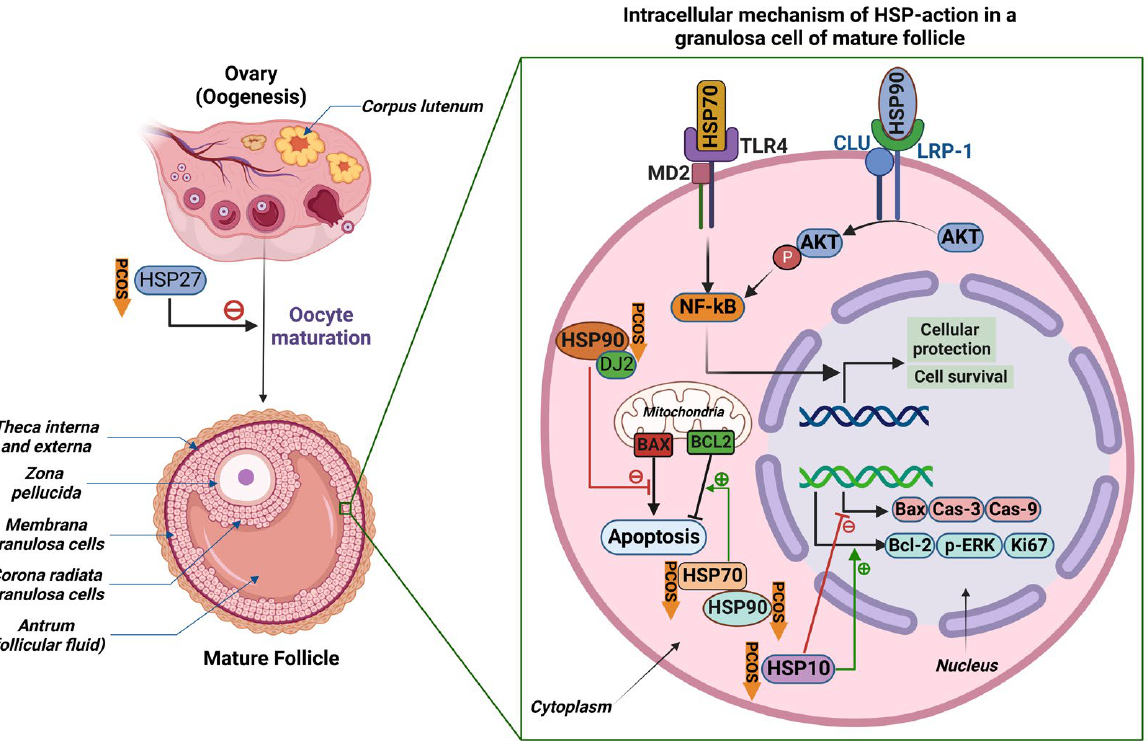
Figure 3. The effect of heat-shock proteins (HSPs) on the pathogenesis of polycystic ovary syndrome (PCOS). ( Left panel ) The stages of oogenesis in the ovary and the structure of a mature follicle. HSPs function at different stages of oogenesis in PCOS. HSP27 negatively regulates oocyte maturation and was downregulated in women with PCOS. ( Right panel ) Intracellular mechanisms of action of HSPs in a granulosa cell (shown in a small green square) of a mature follicle. HSP70 binds to the cell surface toll-like receptor 4 (TLR4) and co-receptor myeloid differentiation protein 2 (MD2). HSP90 binds to the cell surface low-density lipoprotein (LDL)-related protein-1 (LRP-1) in association with clusterin (CLU). Downstream signaling of both HSP70 and HSP90 (phosphorylation of protein kinase B, AKT) leads to the activation of NF-kB, a novel transcription factor that regulates the transcription of genes related to cell survival and protection. HSP90 and its co-chaperone DJ2 (HSDJ/hdj-2/rdj1) inhibit mitochondrial proapoptotic Bcl-2 associated X-protein (BAX). HSP90, in association with HSP70, potentiates the mitochondrial antiapoptotic protein B-cell lymphoma 2 (BCL2). HSP10 regulates the transcription of multiple proteins related to cellular apoptosis. Cas-3, caspase-3; Cas-9, caspase-9; p-ERK, phosphorylated extracellular signal associated kinase; Ki67, marker of proliferation Ki-67. Downward orange arrows labeled “PCOS” indicate the HSPs that were found to be downregulated in PCOS in previous publications. This illustration was created using biorender.com (with publication